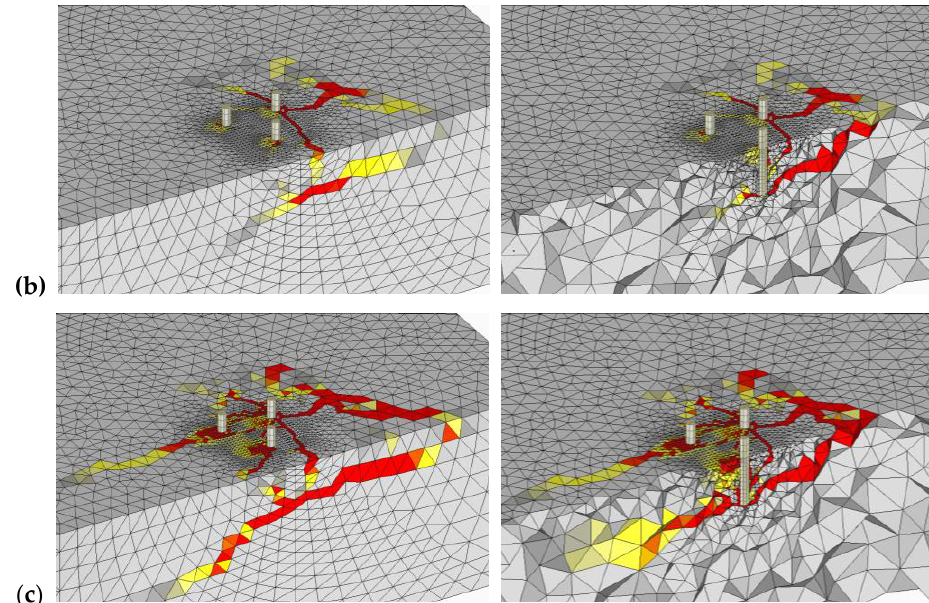
Figure 10. Crack pattern obtained from numerical analysis for Group Tri-B loaded parallel to the edge ( a ) first cracks, ( b ) at peak load, and ( c ) post-peak phase.